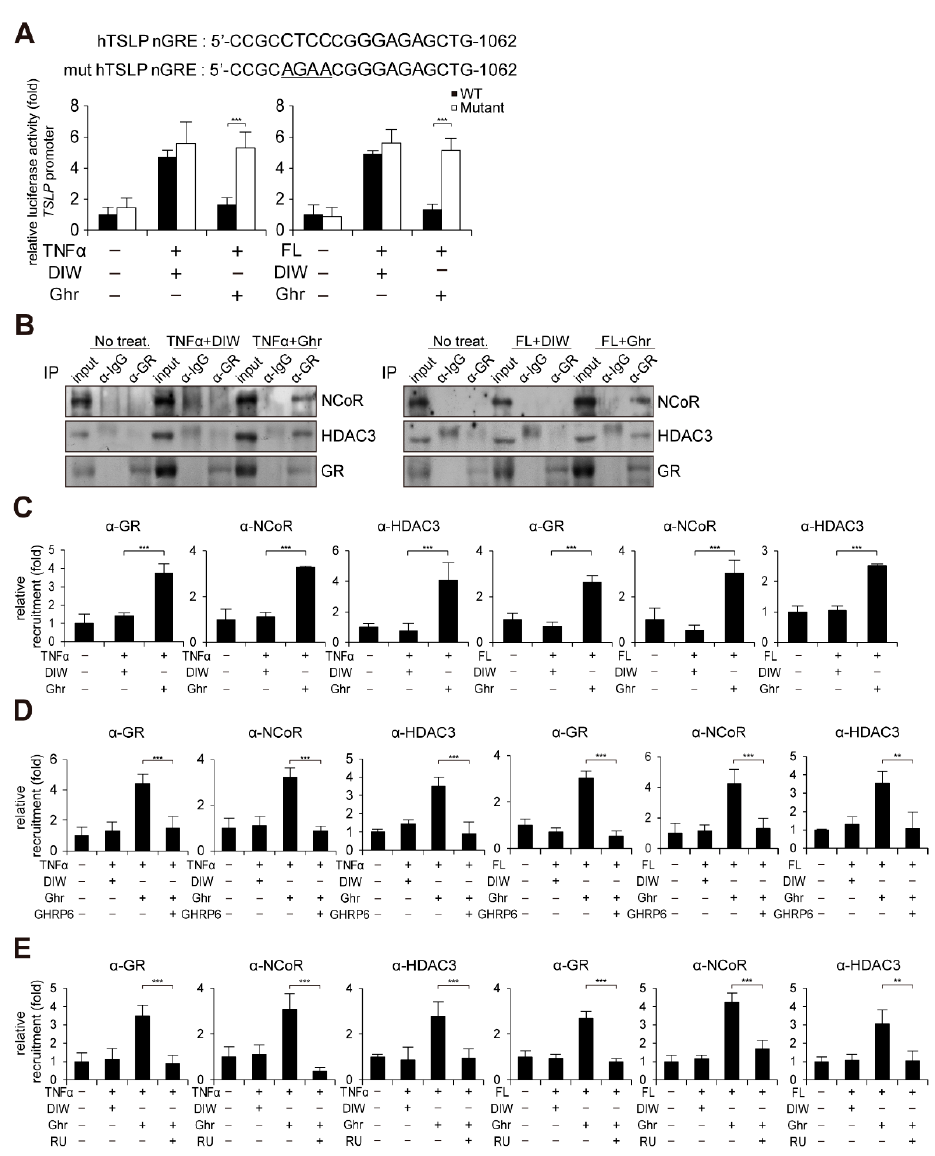
Figure 5. Ghrelin induces recruitment of GR to nGRE site on TSLP gene promoter. ( A ) Mutation of nGRE abolishes ghrelin-induced suppression of TSLP gene promoter activity in HaCaT keratinocytes treated with TNF α or bacterial flagellin (FL). After HaCaT keratinocytes were transiently transfected with luciferase reporter vector containing the TSLP gene promoter and control Renilla luciferase expression vector, luciferase activity was measured ( n = 3). Mutated nucleotides are underlined. DIW was used as solvent for TNF α , flagellin, and ghrelin. ( B ) Ghrelin induces interaction of GR with NCoR and HDAC3 in HaCaT keratinocytes treated with TNF α or bacterial flagellin. HaCaT keratinocyte lysates were immunoprecipitated with the anti-GR antibody, then immunoblotted with anti-NCoR, anti-HDAC3, and anti-GR antibodies ( n = 3). IgG was used as a control. Representative images are shown. ( C ) Ghrelin induces the recruitment of GR, NCoR, and HDAC3 to the nGRE site on the TSLP gene promoter. ChIP assay was performed using anti-GR, anti-NCoR, and anti-HDAC3 antibodies ( n = 3). The occupancy of each protein was quantified using real-time PCR at the gene promoter encompassing the nGRE site. IgG was used for negative control. ( D ) GHRP6 abolishes ghrelin-induced recruitment of GR, NCoR and HDAC3 to the nGRE site on the TSLP gene promoter ( n = 3). ( E ) RU486 (RU) abolishes ghrelin-induced recruitment of GR, NCoR, and HDAC3 to the nGRE site on the TSLP gene promoter ( n = 3). All data represent mean ± S.E.M. Significance values were ** p ≤ 0.01 and *** p ≤